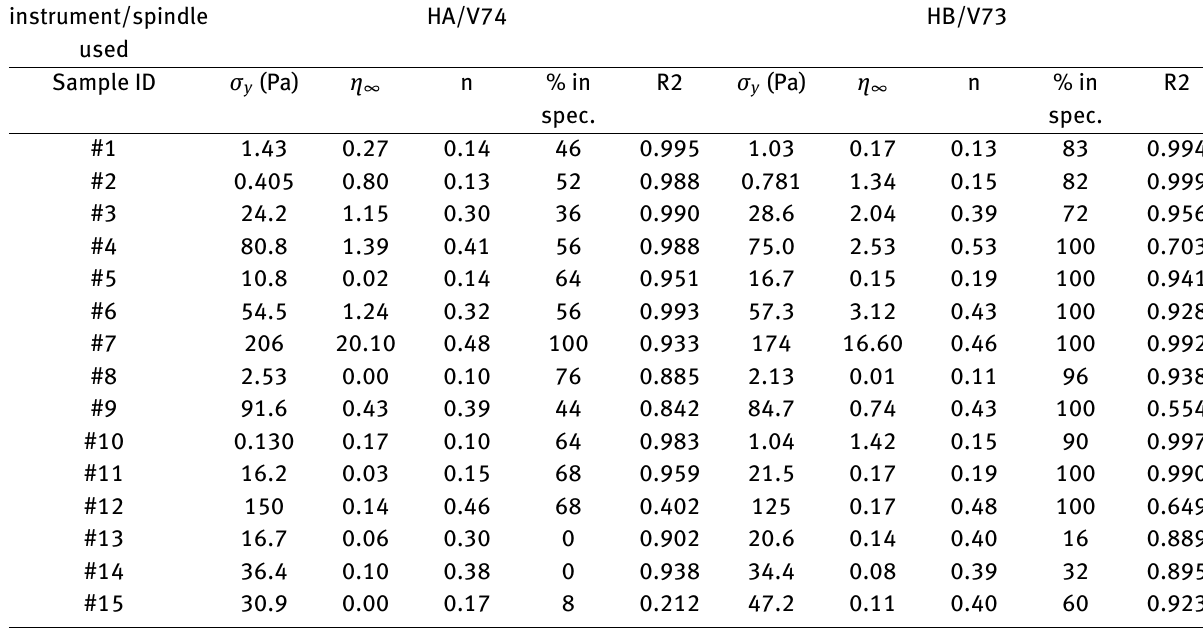
Table 3: Fitting parameters for the flow curves obtained with the two configurations: HA type viscometer with V74 spindle and HB with V73 spindle for all fluids from Table 1. Also shown are coeflcients of determination estimated when using Brookfield data as a predictor for the data obtained on ARG2 rheometer as explained in the text and the percentage of points which produced the torque above 10% (usually considered “in-spec” by Brookfield).